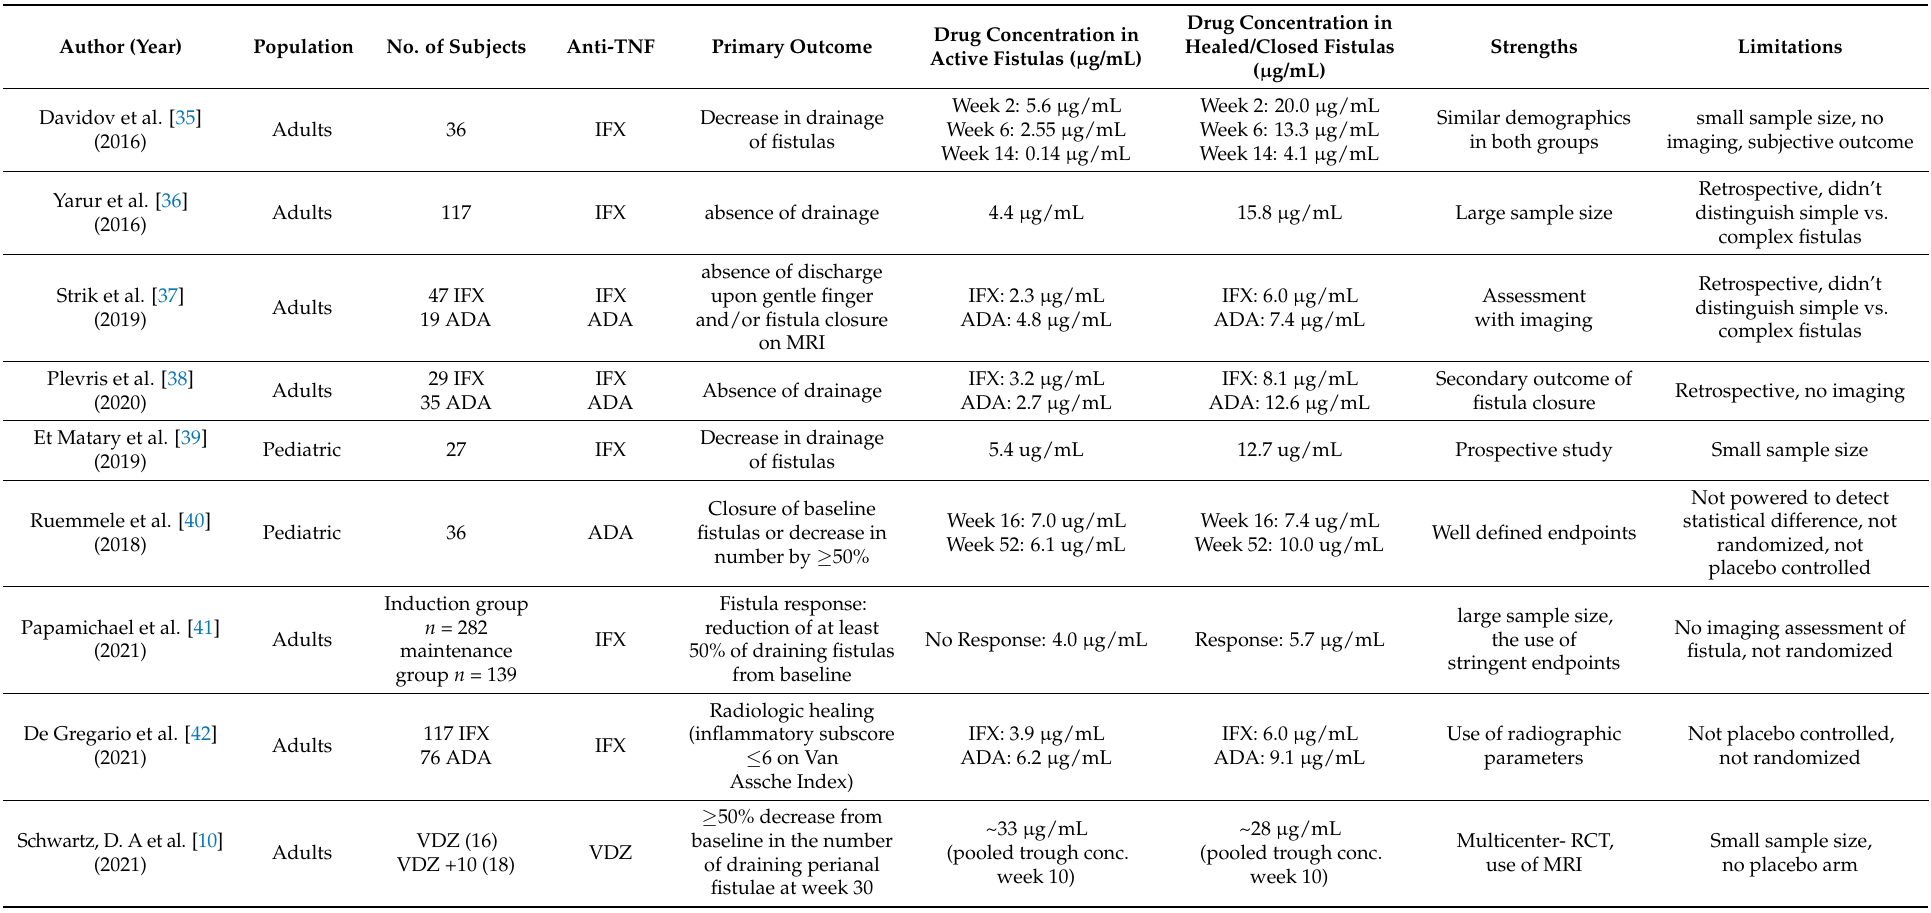
Table 1. Studies demonstrating association between increased biologic drug levels with fistula healing in